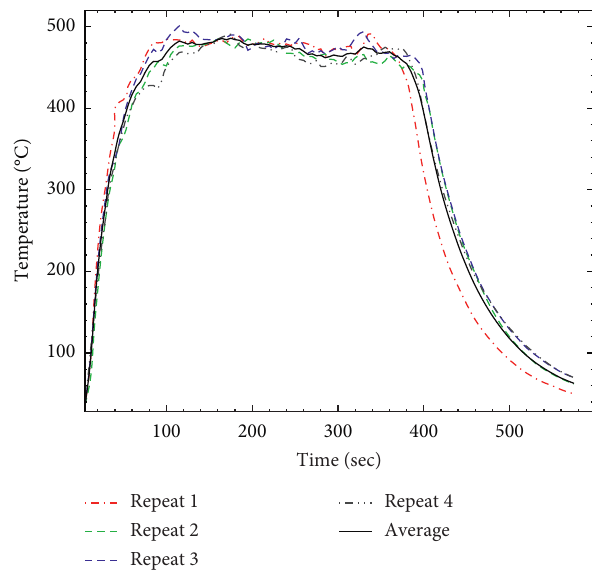
Figure 4: Flame temperature versus time: case study of free fire with fire source 1.